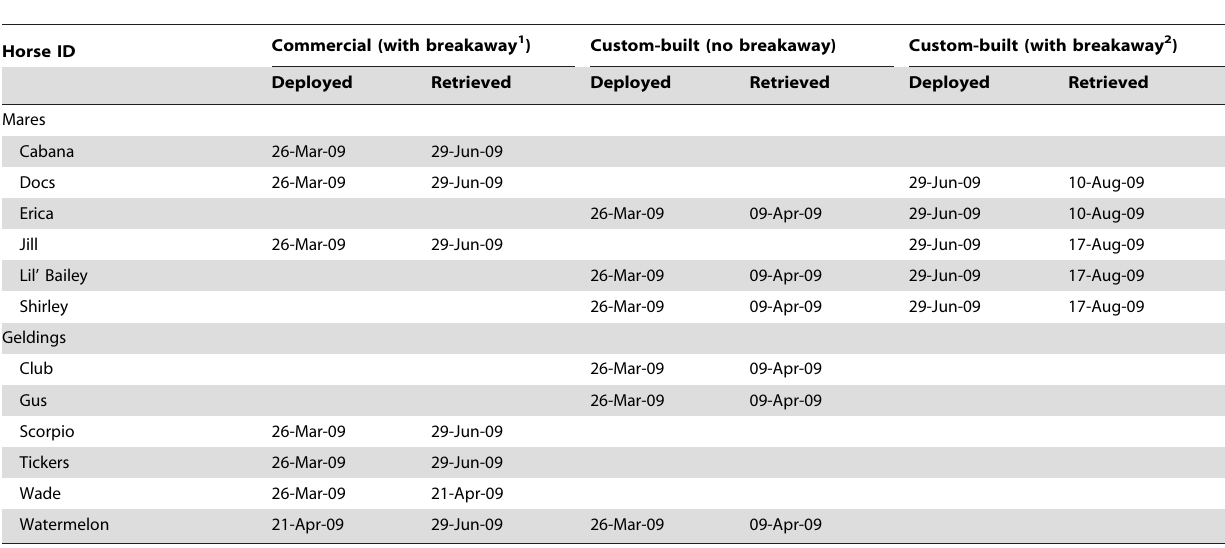
1 Remotely-detonated breakaway detachment device. 2 Breakaway detachment device constructed of rubber